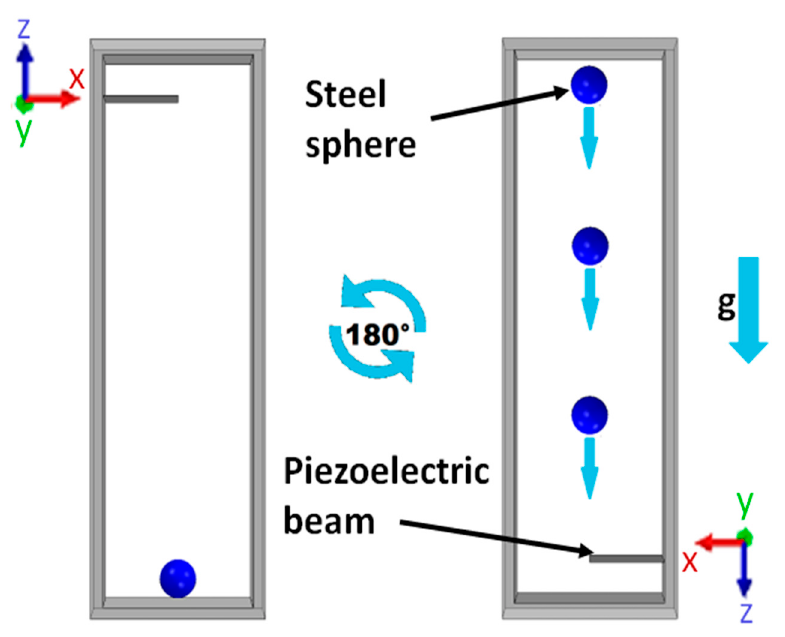
Figure 1. Illustration of the theoretical instantaneous 180° rotation of the device and the impact mechanism.